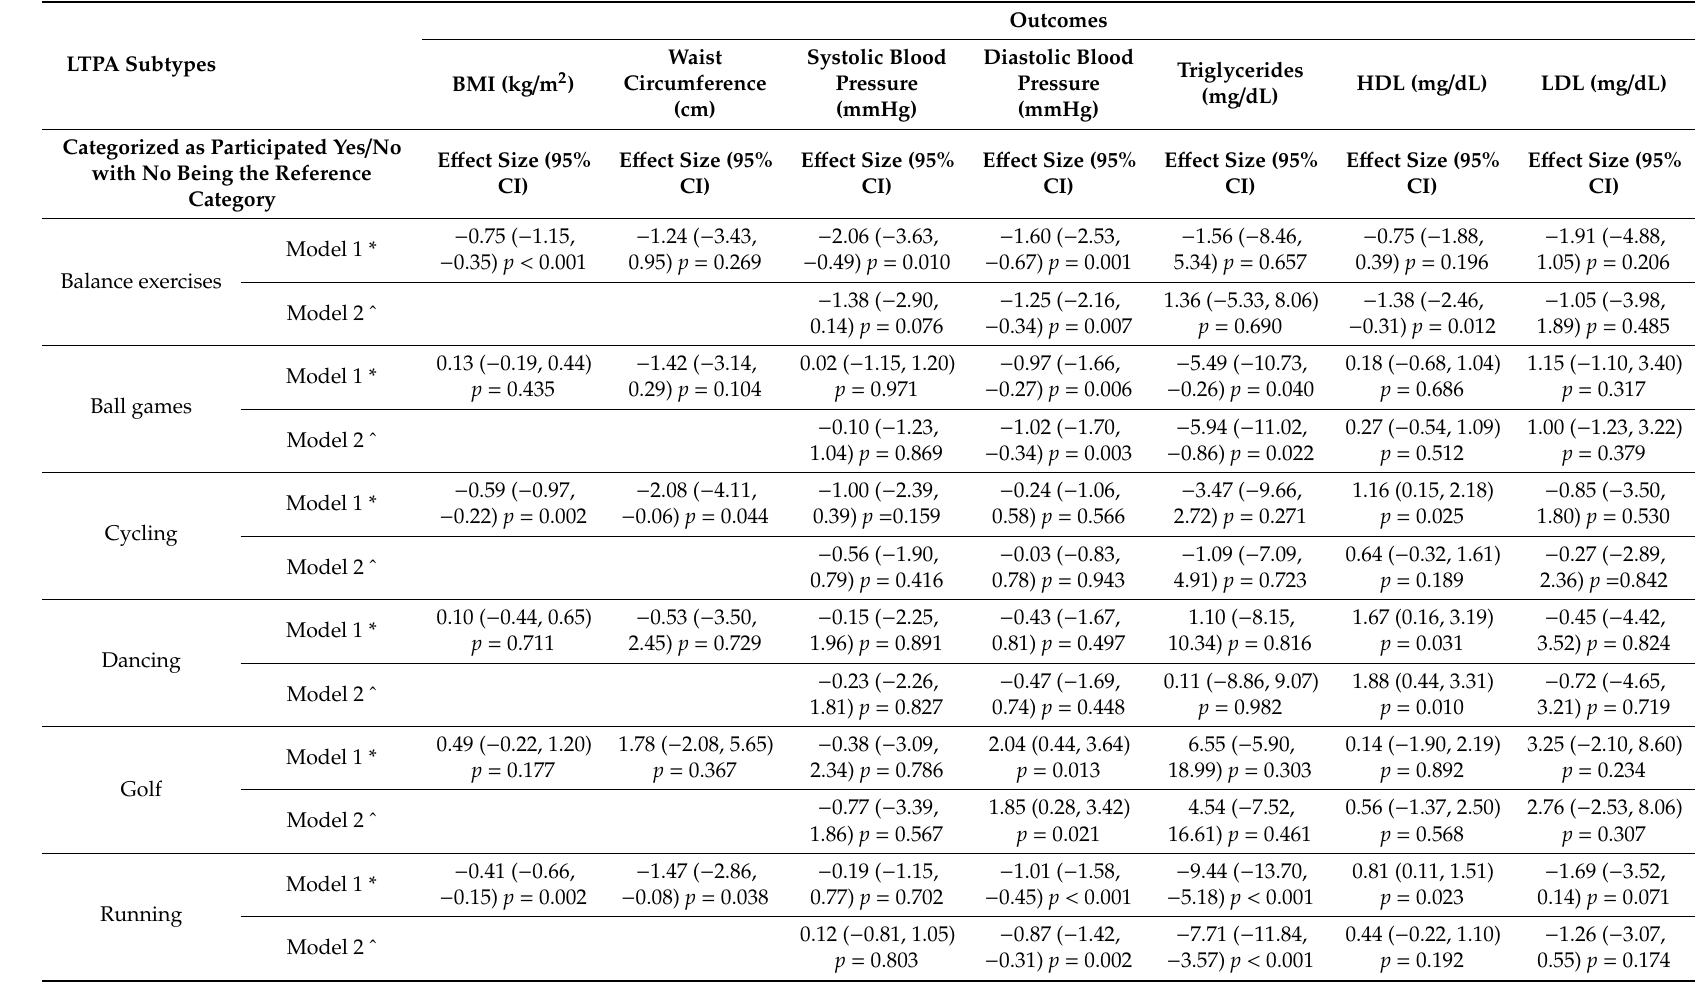
Table 3. Association between cardiometabolic measures and leisure time physical activity (LTPA)